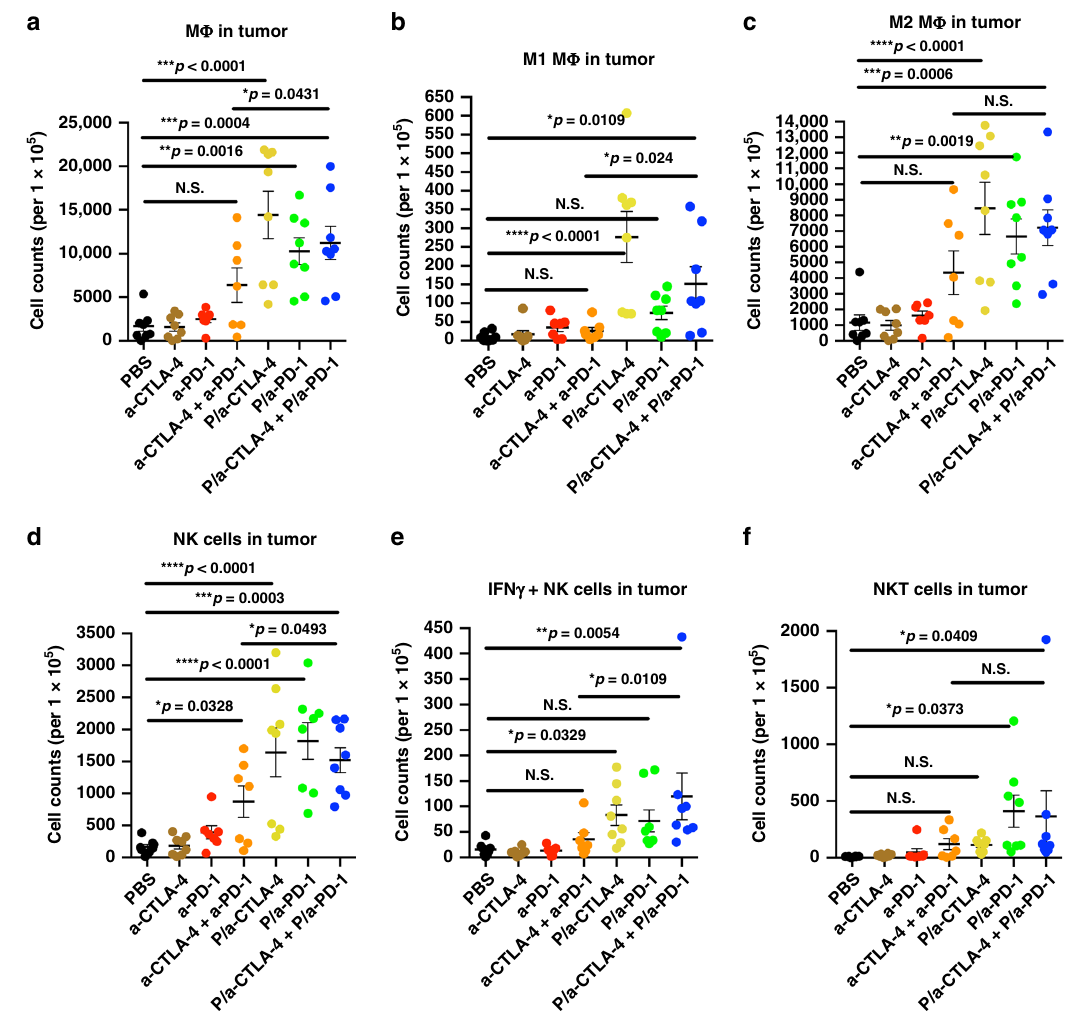
Fig. 5 Increase of tumor macrophages, NK and NKT cells by fl ow cytometry. GL261 brain tumors were analyzed by the spectral fl ow cytometry (SONY Biotechnology) and various types of tumor-associated immune cells are presented as the cell counts in each treatment group. a Macrophages (M Φ ): CD3- F4/80 + ; b M1 type M Φ : CD3-F4/80 + iNOS + CD206-; c M2 type M Φ : CD3-F4/80 + CD206 + iNOS − ; d Natural killer (NK) cells: CD3-NK1.1 + ; e Interferon γ + NK cells; f NKT cells: CD3 + NK1.1 + . Approximately 100,000 events/sample are recorded and analyzed by the SA3800 software (SONY Biotechnology). Data are mean ± SEM. * p < 0.05;. ** p < 0.01; *** p < 0.001; **** p < 0.0001; N.S. = non-signi fi cant (one-way ANOVA with Sidak ’ s posttest). N